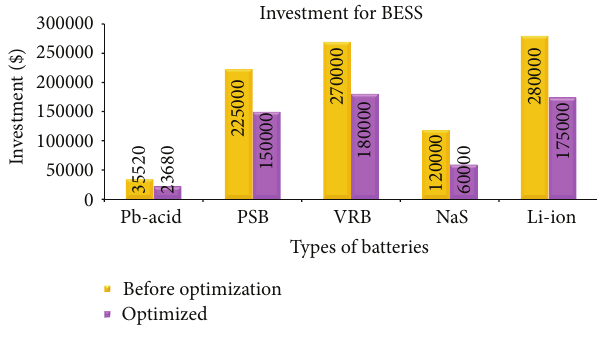
Figure 10: Investment for